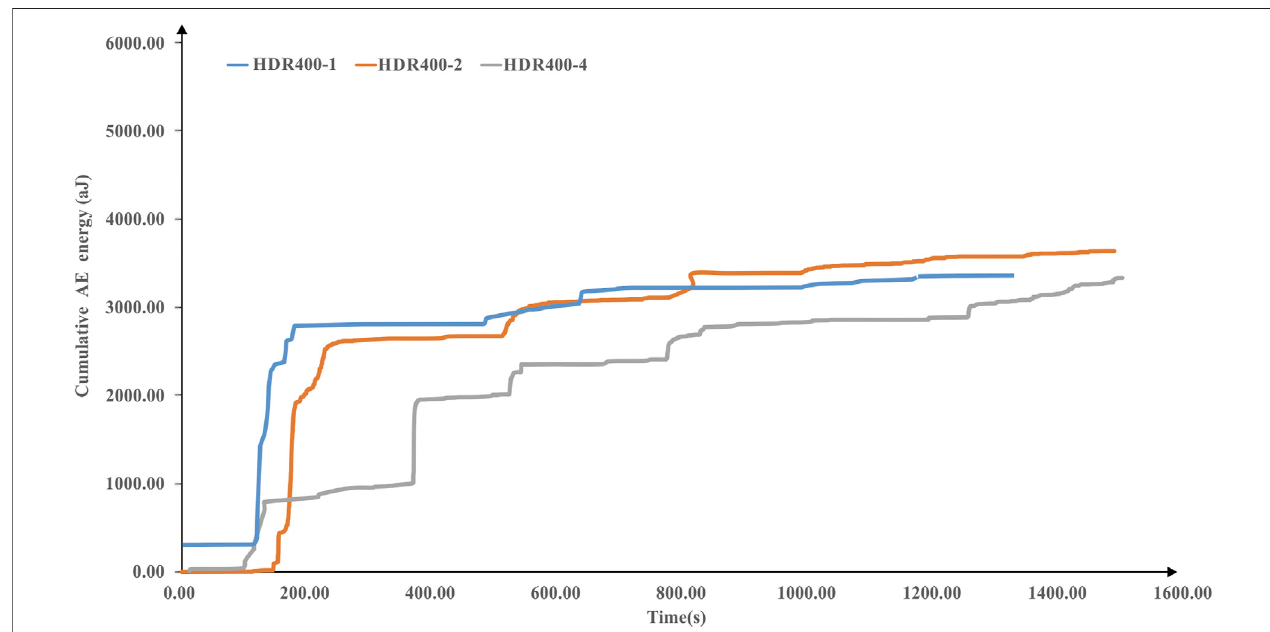
FIGURE 10 | Cumulative AE energy over